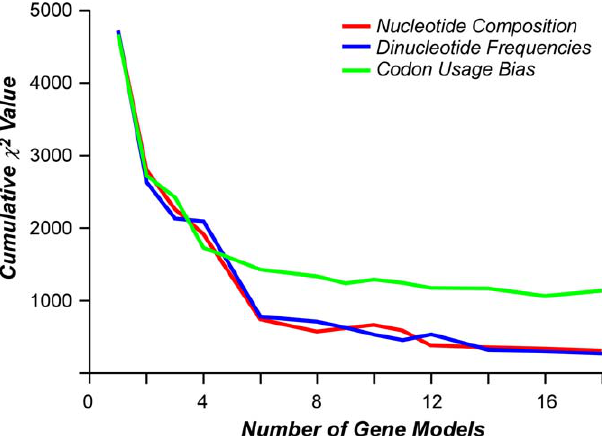
Figure 2 Goodness-of-Fit between Genuine and Artificial Genomes Created with Variable Numbers of Gene Models Genes within the genuine E. coli genome were clustered by nucleotide composition, frame-specific DNC, or CUB patterns. Correspondence between genuine and artificial genomes was calculated as the v 2 of the distributions of percent GC for the three-codon positions. Small v 2 values correspond to closer approximations. DOI: